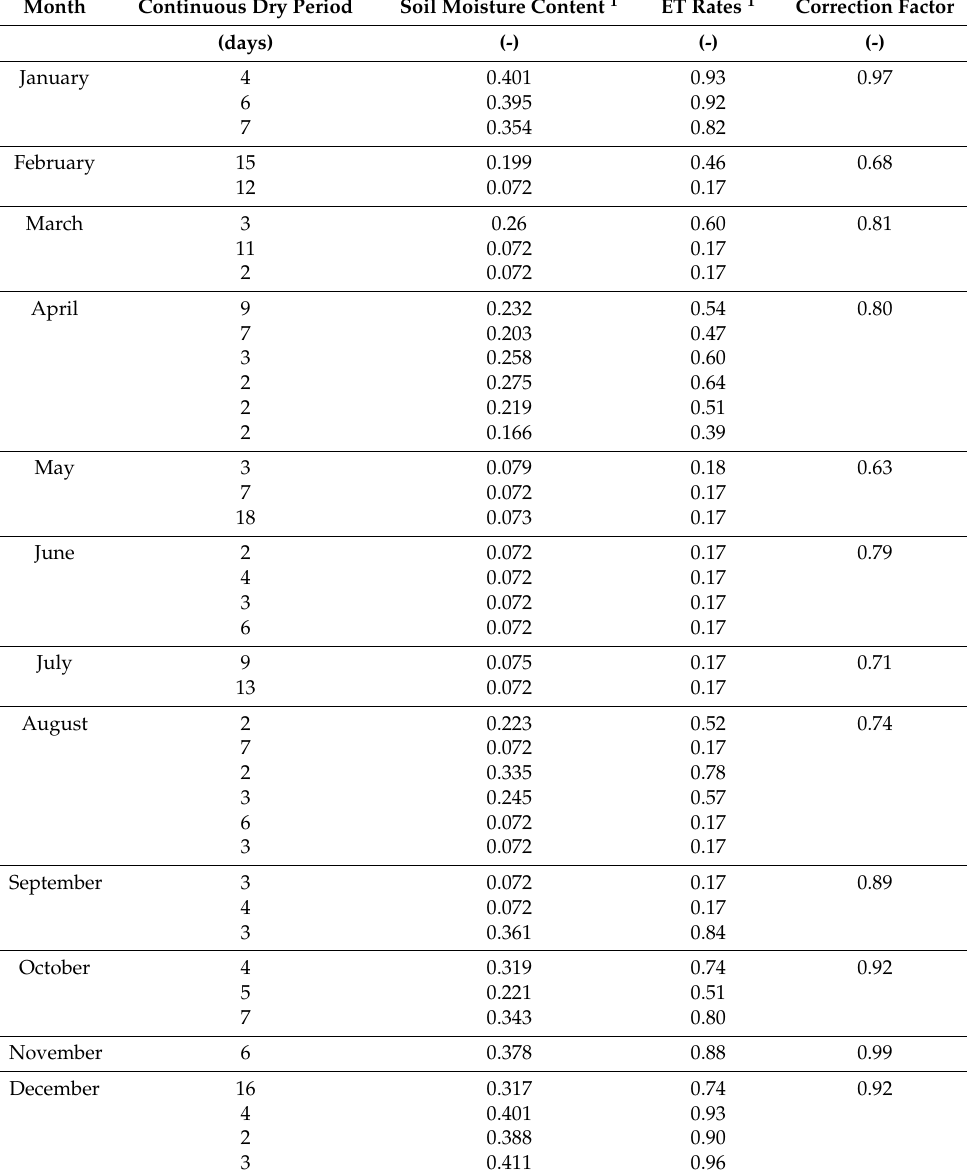
Table 4. Monthly correction factors calculated after Peng and Stovin [18]. Soil moisture content and evapotranspiration (ET) rates (proportion of potential evapotranspiration (PET)) are evaluated at the end of the dry period; the reported data are referred to the 1999 year of the Villa Cambiaso (Genoa, Italy) time series climate